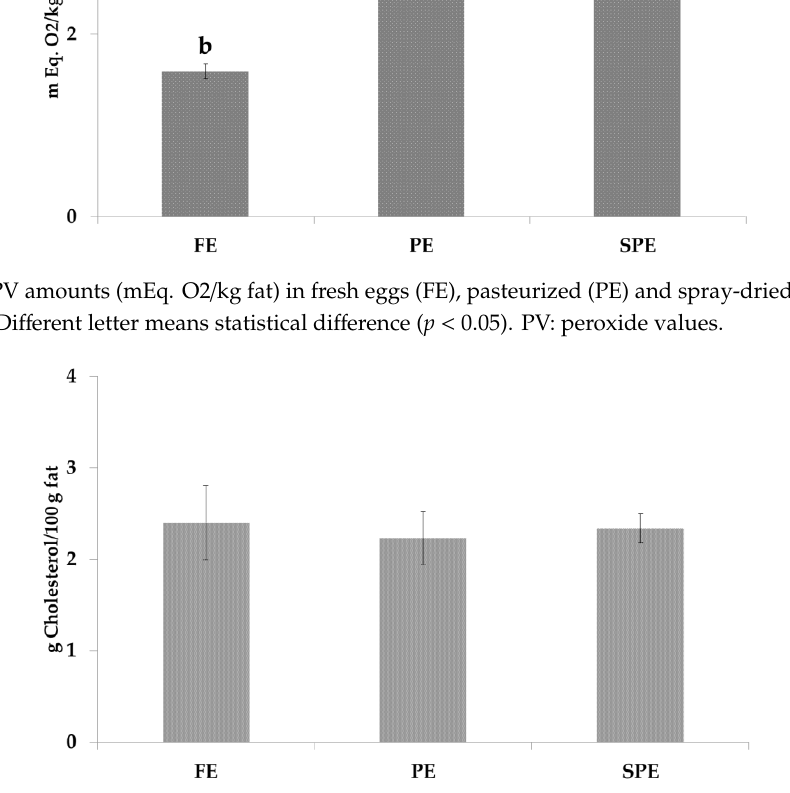
Figure 2. Cholesterol content in fresh eggs (FE), pasteurized eggs (PE) and spray-dried (SPE) egg products .